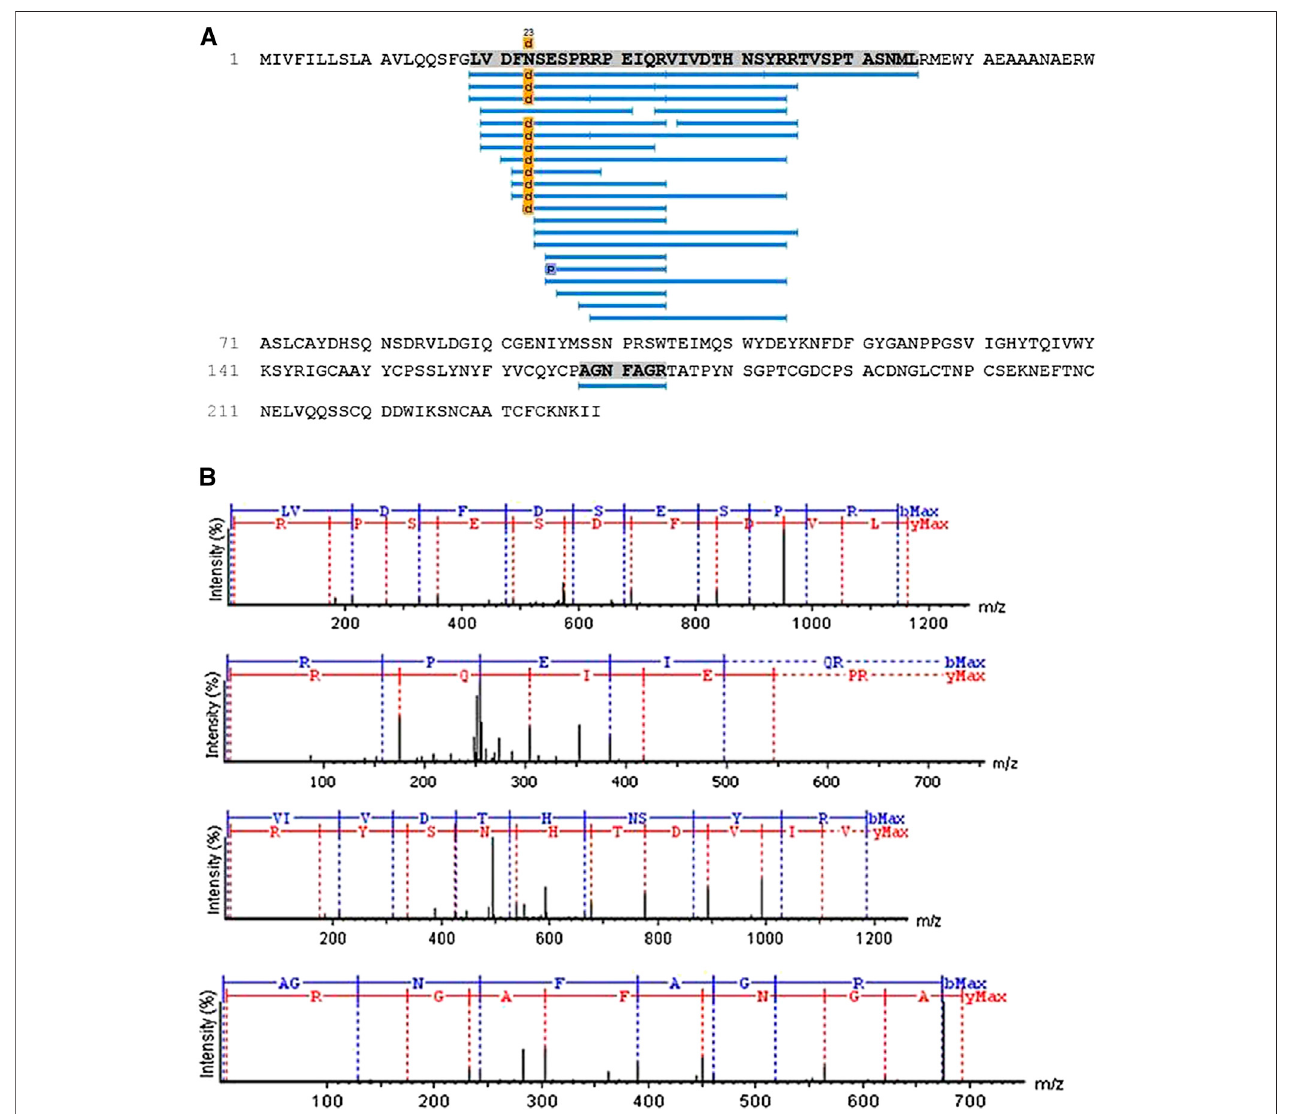
FIGURE 2 | Patagonin-CRISPidenti fi cation. (A) Through PEAKS Studio analyses with the Uniprot database, a cysteine-rich venom protein from Philodryas olfersii (AAZ75603.1)wasidenti fi edbythepresenceofsomeuniquefragmentsinourmolecule. (B) Theuniquepeptidefragmentsobtainedwith99%ALC.Theionsbelongingto they(red)andb(blue)series,indicatedinthespectrum,correspond totheaminoacidsequencesofthepeptideLVDFDSESPRRPEIQRVIVDTHNSYRRandAGNFAGR.